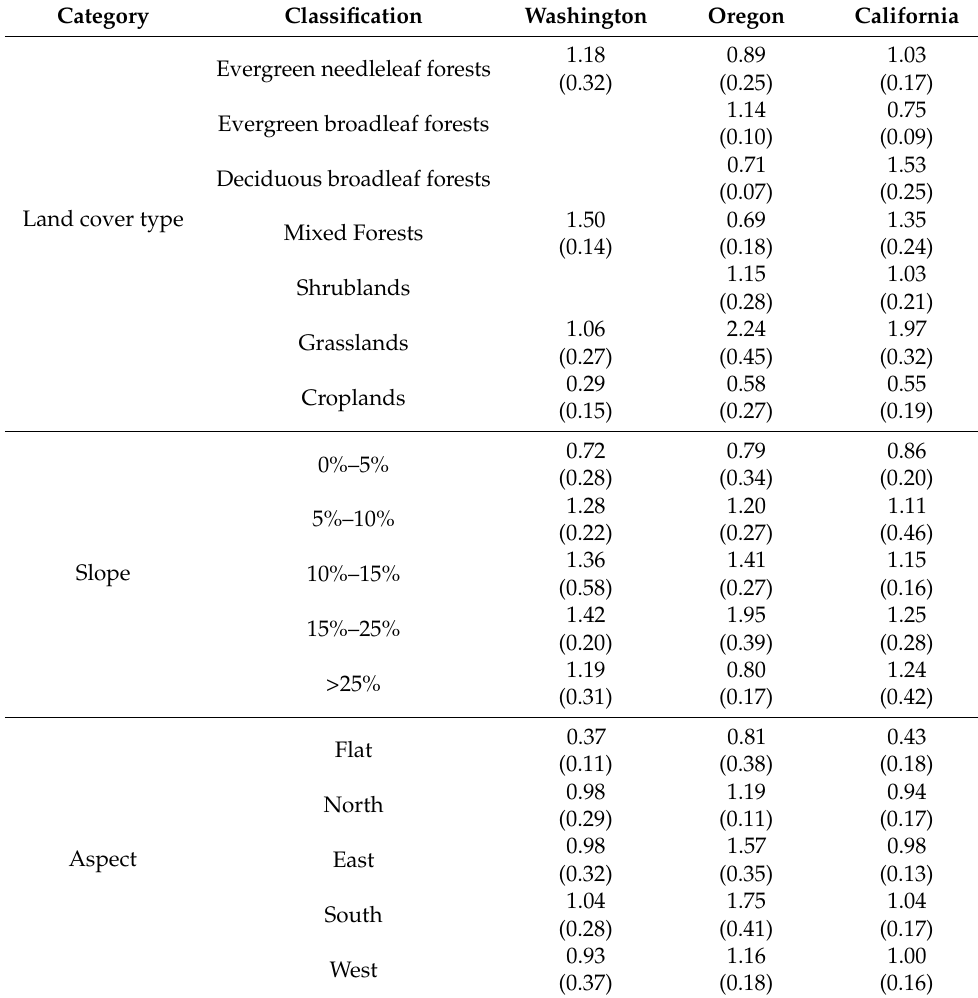
Table 1. Average selection ratios with 95% confidence intervals in the parenthesis for land cover, slope, and aspect for Washington, Oregon, and